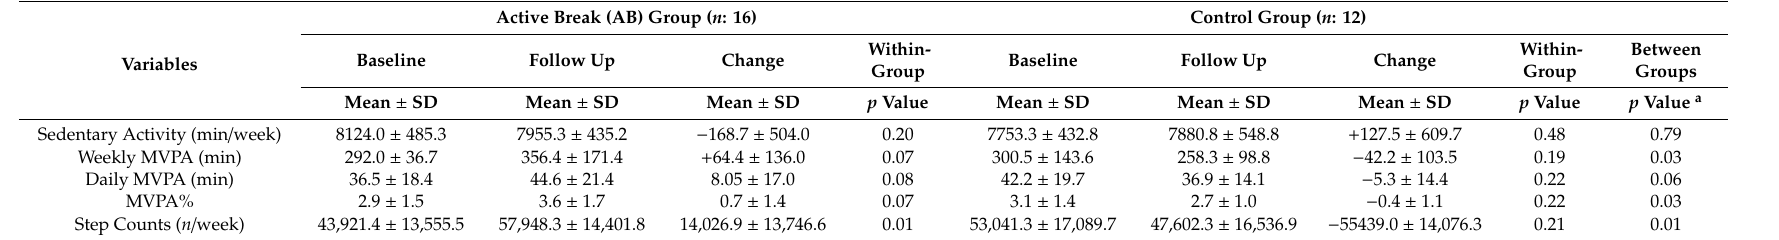
Table 2. Outcome measures at baseline, follow-up and changes at 14